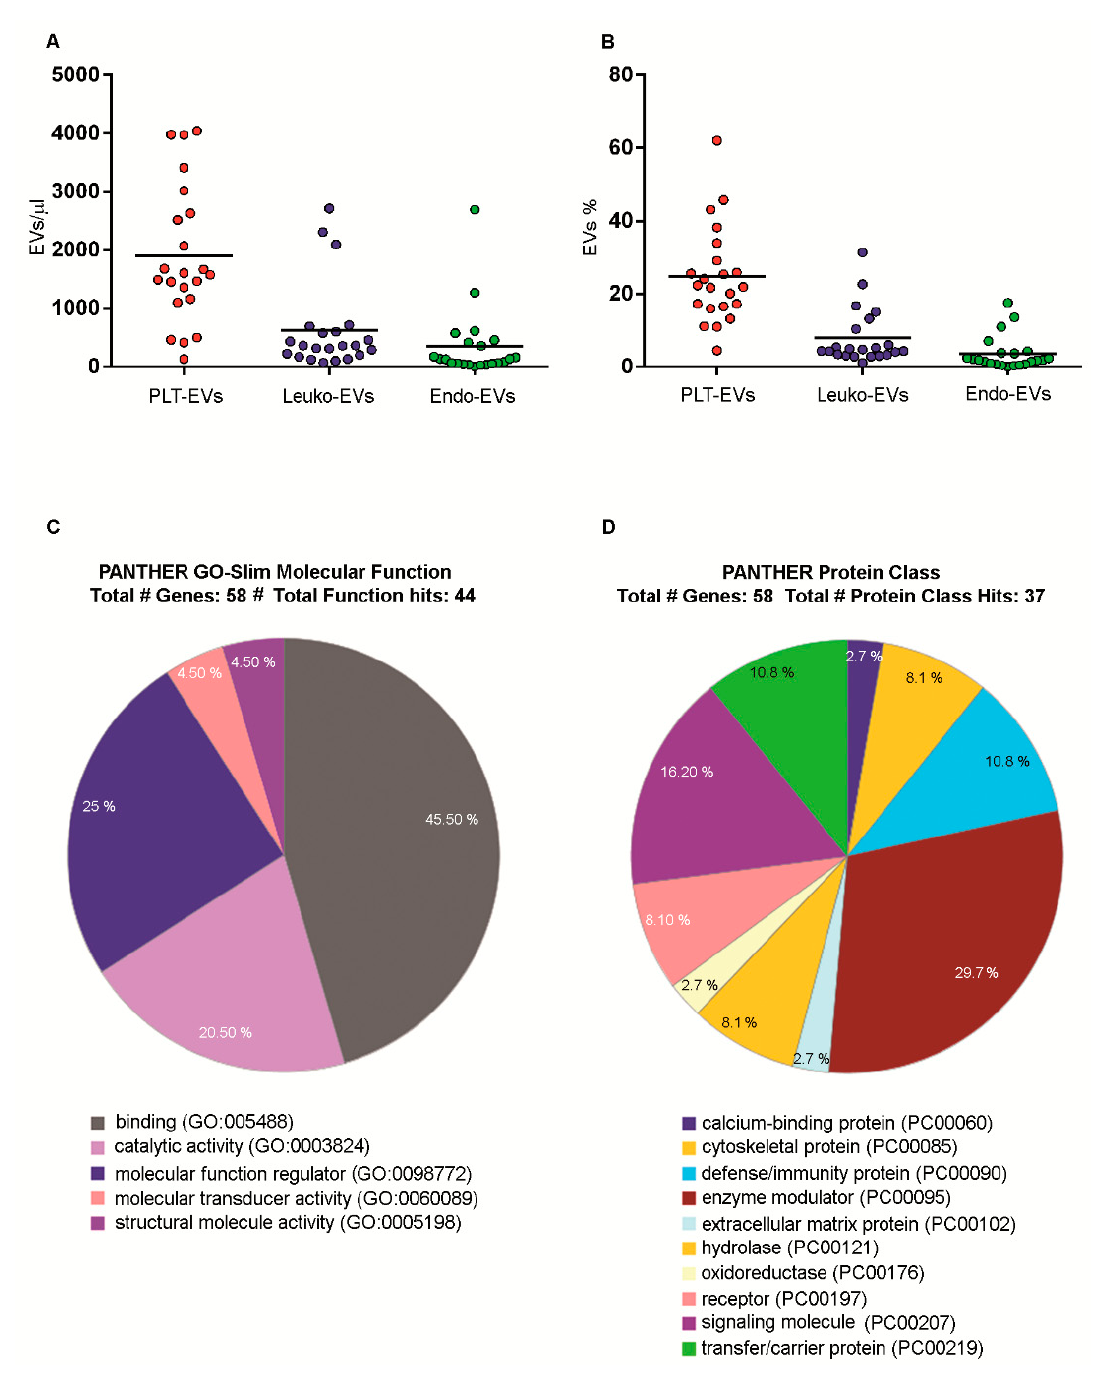
Figure 4. Extracellular vesicle concentrations and percentages. ( A ). The scatter plots represent absolute counts of Platelet-, Leukocyte- and Endothelial-derived EVs. Values are expressed as events/ µ l. Horizontal lines represent related mean values. ( B ). Scatter plots represent percentages of Platelet-, Leukocyte- and Endothelial-derived EVs. Values are expressed as percentages of total EVs. Horizontal lines represent related mean values. ( C , D ). Proteins from sorted EVs preparations were identified by LC MS/MS, then analyzed using PANTHER analysis and finally classified by the Molecular function ( C ) and the Protein class ( D ).